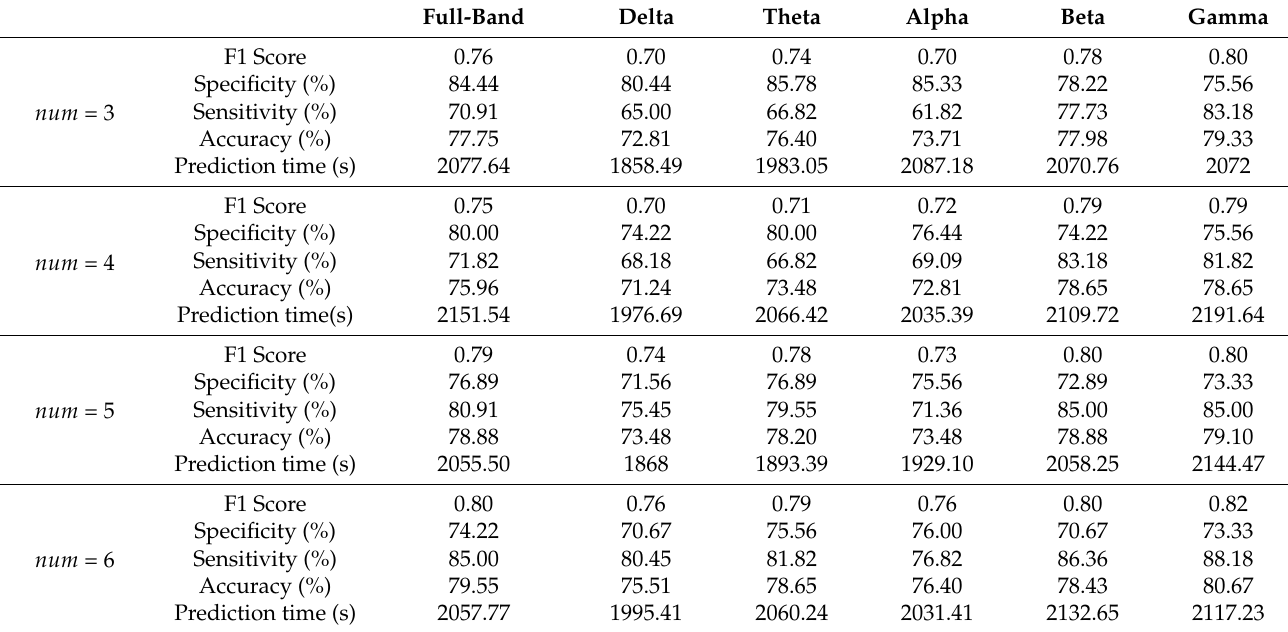
Table 4. This table shows the prediction results of the features extracted by tensor